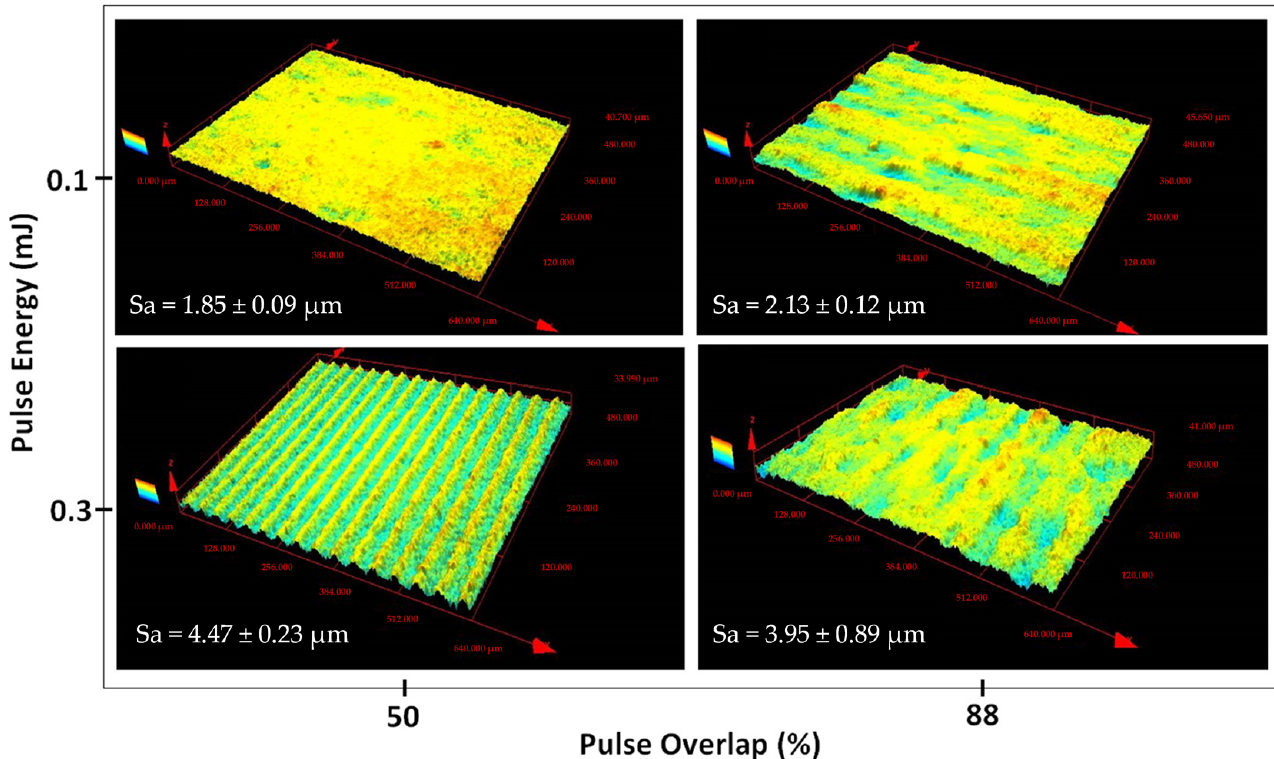
Figure 8. Three–dimensional surface topography image by confocal laser scanning microscope. Re- printed/adapted with permission from Ref. [144]. Copyright 2016, Elsevier.